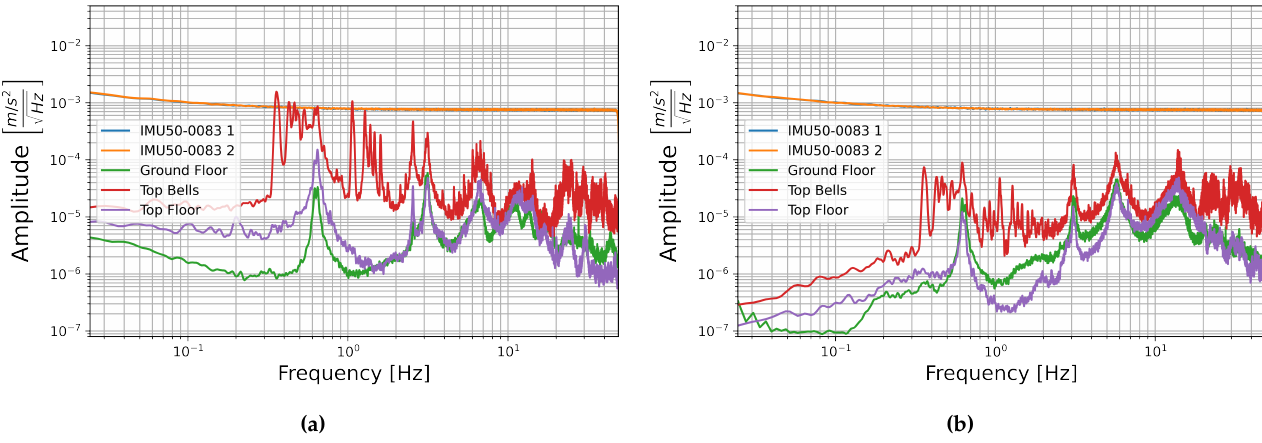
Figure 16. The square root of the PSD of self-noise recordings from sensor number 0083 compared with building noise recorded in Giotto’s Bell Tower on the Ground floor (blue), top floor (orange), and top floor with three bell tolls (green) compared for ( a ) horizontal sensor component HNY with seismometer component HHN and ( b ) vertical sensor component HNZ with seismometer component